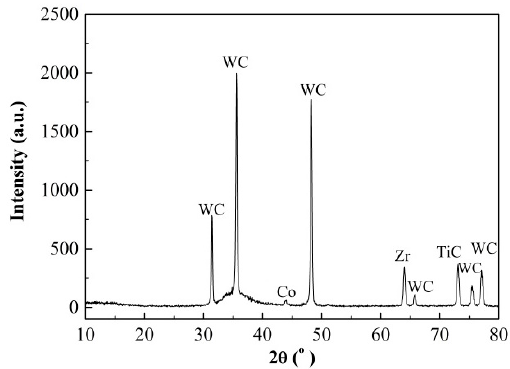
Figure 5. X-ray diffraction analysis of the composite coatings with Zr current of 30 A.